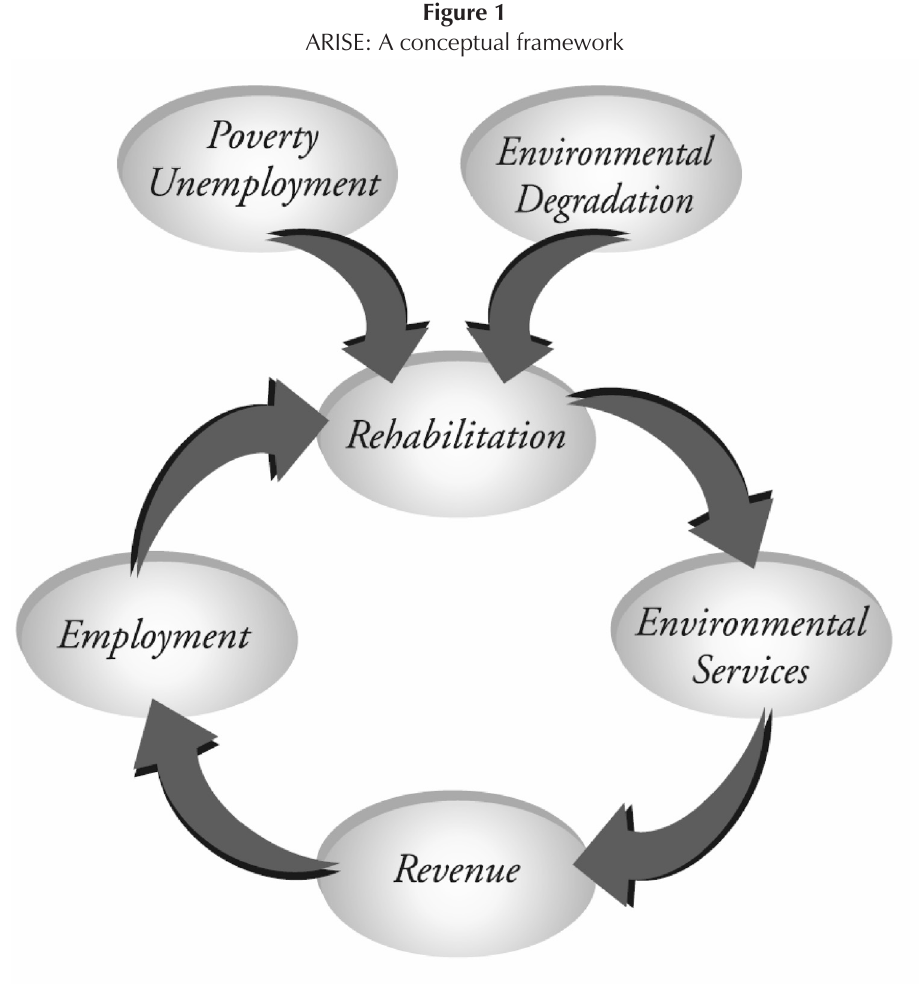
ARISE: A conceptual